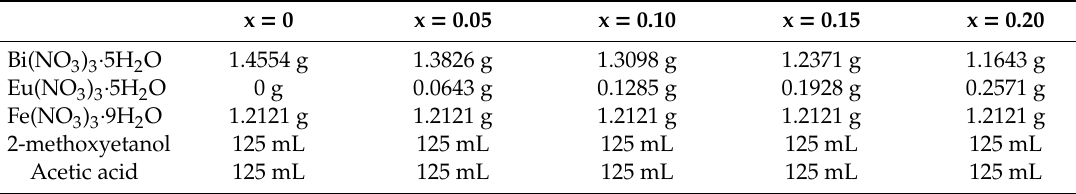
Table 1. Amounts of precursors for Bi 1 − x Eu x FeO 3 sol-gel synthesis. x =